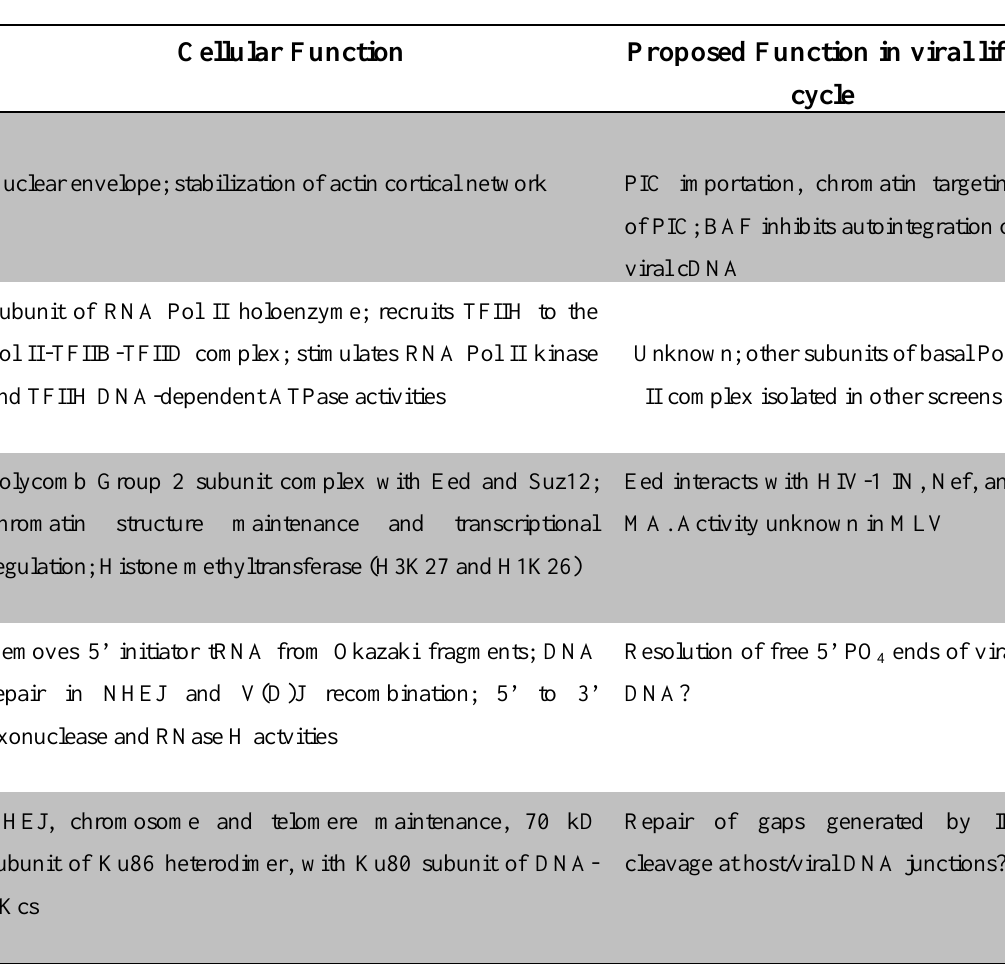
Table 1. A compilation of selected host gene products identified as interacting with the MLV